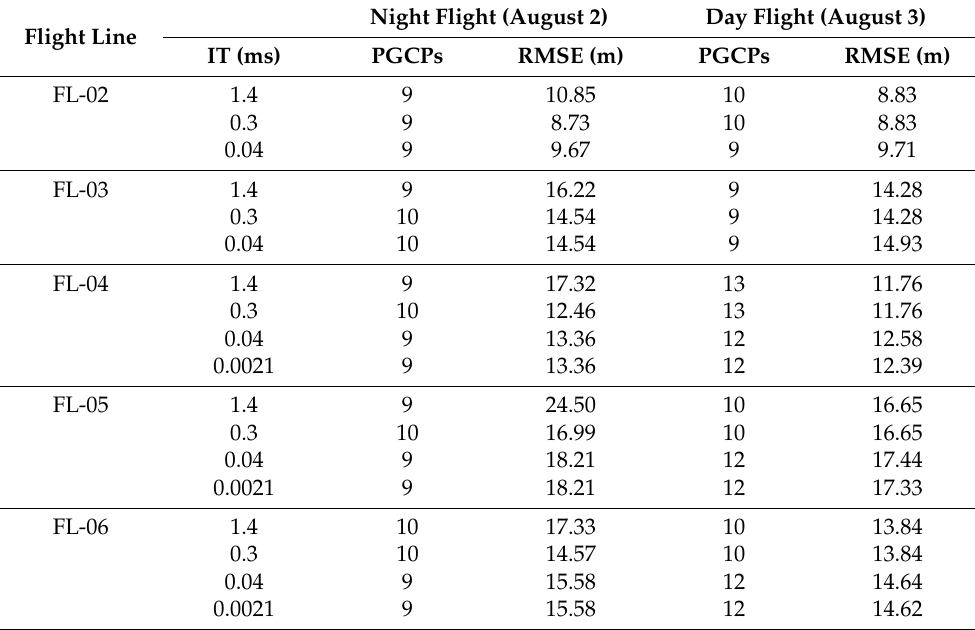
Table 6. Reported total RMSE (m) of pseudo-ground control points (PGCPs) for data acquired during night flight (F-03, 2 August) and day flight (F-04, 3 August) during the 2017 campaign over the SLK-37